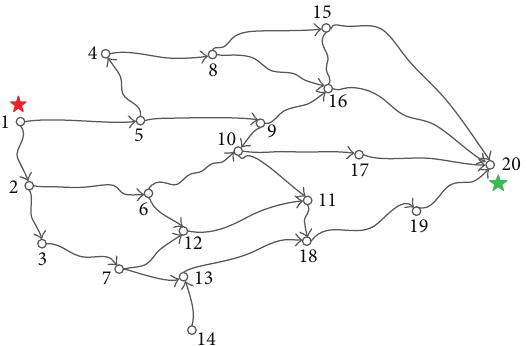
Figure 1: A directed transportation network with 20 nodes used in [16].